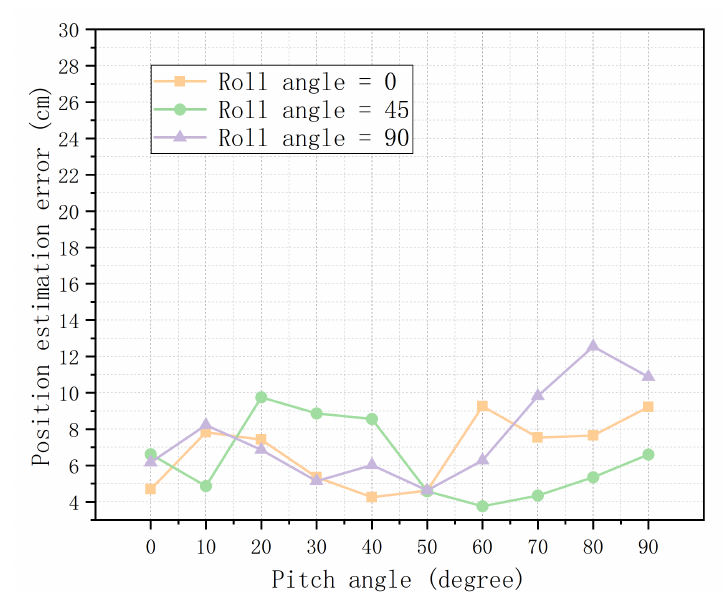
Figure 12. Position error accuracy of the initial value estimation method for the Kalman filter (KF) and the extend Kalman filter (EKF) (IVE-KF) algorithm at different posture angles.